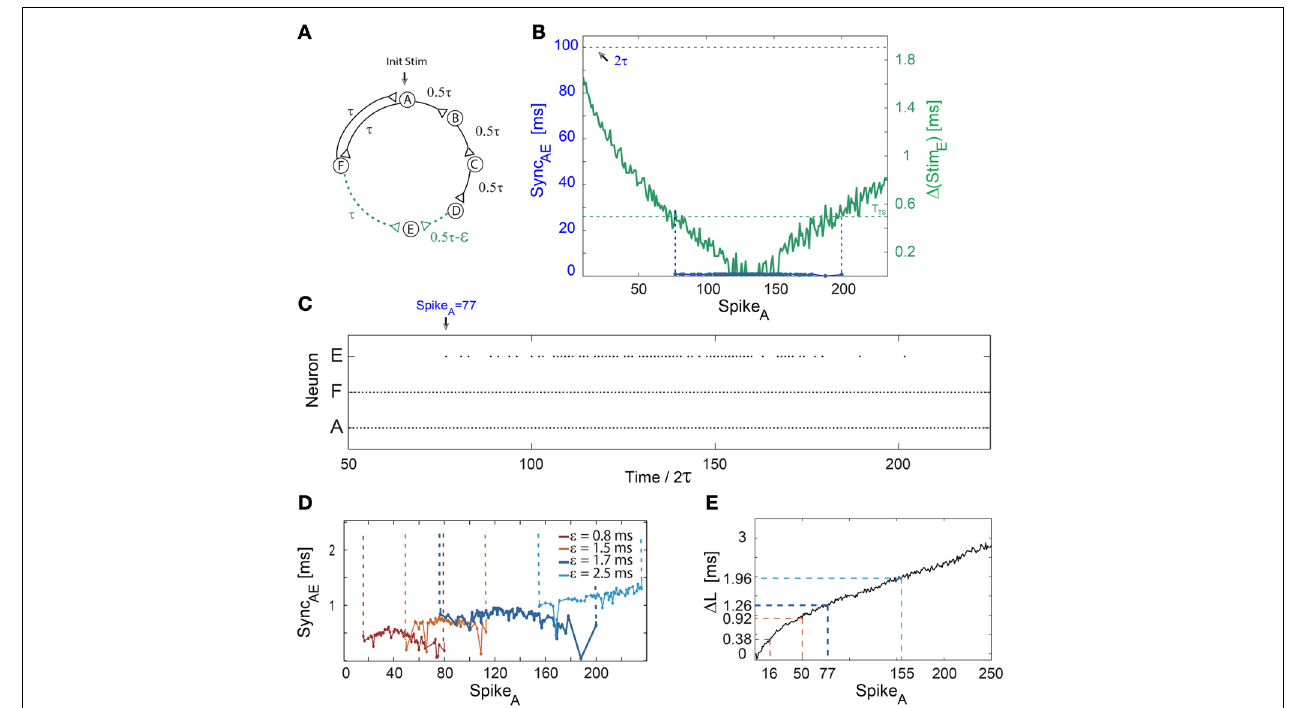
FIGURE 3 | Short epochs of synchrony not accompanied by a change temporary firing of E terminates after ∼ 200 spikes of neuron A. (C) Spike in frequency. Notations used: Sync AE , the absolute time-lag between the trains of neurons A, F, and E, indicating a steady firing frequency ( ∼ 10Hz) spikes of neurons A and E; (cid:2) (Stim E ), the absolute time difference of the neuronal circuit independent of the firing of neuron E, where an between two weak stimulations to neuron E; (cid:2) L , defined as epoch of synchrony, Sync AE ≈ 0, begins at time/2 τ = 77 (at spike 77 of + (cid:2) L + (cid:2) L − (cid:2) L (cid:2) L neuron A). (D) The number of spikes prior to the firing of neuron E B C D F . (A) Schematic of a neuronal circuit consisting of six neurons and weak/strong stimulations represented by dashed increases with ε . The mild increase in the firing mismatch, Sync AE , is attributed to the additional increase by ε of the initial 2 τ delay loop (E fires (green)/full (black) lines. (B) Experimental measurements of (cid:2) (Stim E ), ∼ 2 τ + ε laggard to A, however, the time-gap between consecutive firings similar to (cid:2) (Stim C ) in Figure 1B , with ε ≈ 1 . 7ms, τ = 50ms and T TS ≈ 0 . 5ms (presented by the dashed horizontal green line). The time of A is ∼ 2 τ + 2 ε ). The data for ε = 1 . 7 (blue) is the same as in (B,C) . (E) (cid:2) L for repeated stimulations at 10Hz. (cid:2) L at the synchrony leap for delay between neurons A and E, ∼ 2 τ , is denoted by the dashed horizontal black line. The firing region of neuron E (blue dots bounded by dashed different ε are colored following (D) . The number of spikes per neuron vertical guidelines), which is at nearly zero-lag synchronization with the (e.g., Spike A ), n , until the leap to synchrony increases with ε and can be obtained from Equation (1), where (cid:2) L D is substituted by (cid:2) L firing of neuron A, Sync AE ≈ 0, starts after 77 spikes of neuron A. The